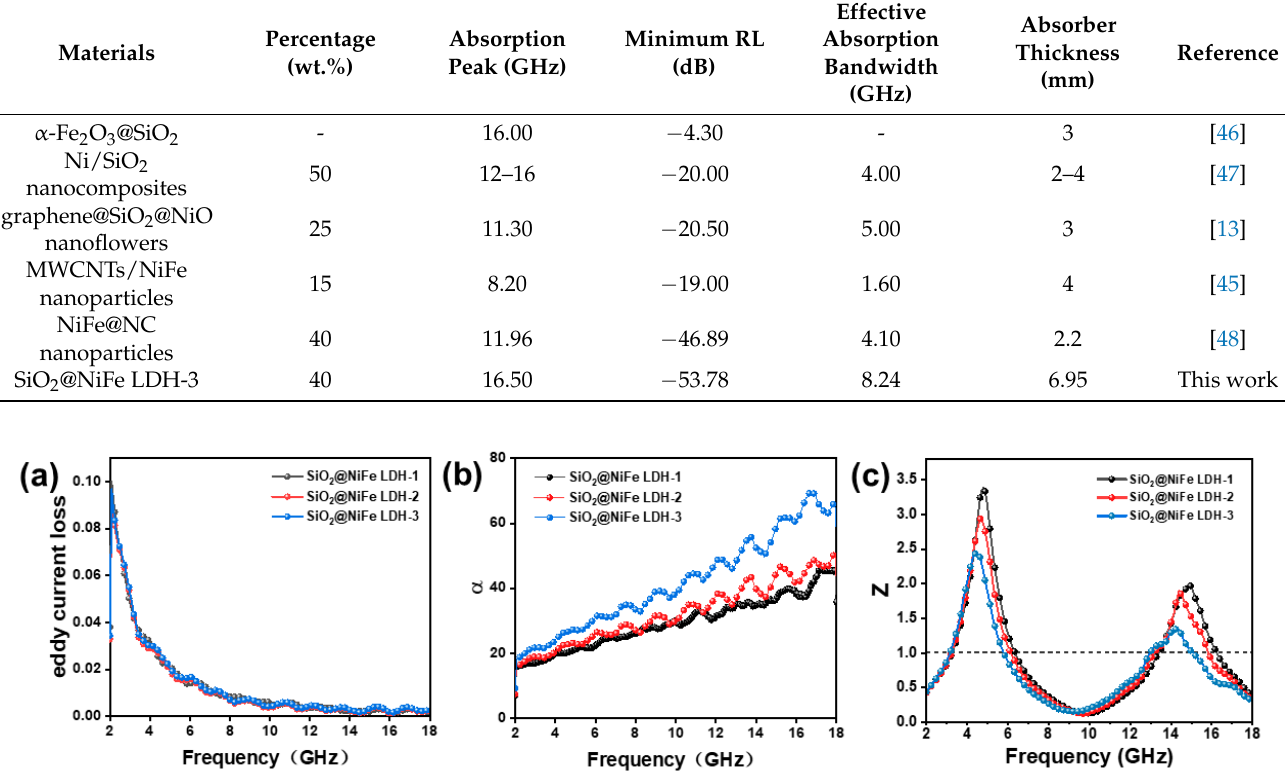
Figure 5. ( a ) Frequency dependence of eddy current loss, ( b ) attenuation constant and ( c ) impedance matching Zr of the SiO 2 @NiFe LDH-1, 2, 3.